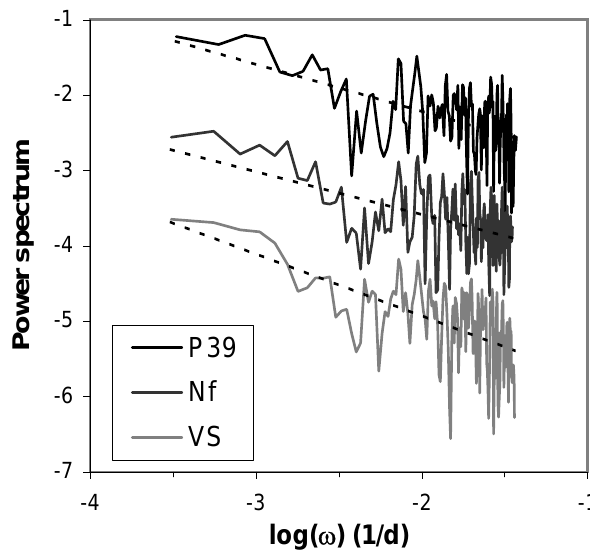
Fig. 8. Power spectra of unevenly sampled isotope series from sites P39, VS and Nf, computed by the Lomb periodogram method. The dotted lines are the best fit of a power law distribution of the spectral frequencies. Lomb periodograms were computed by the source routine available at http://www.physionet.org/physiotools/wfdb/psd/lomb.c